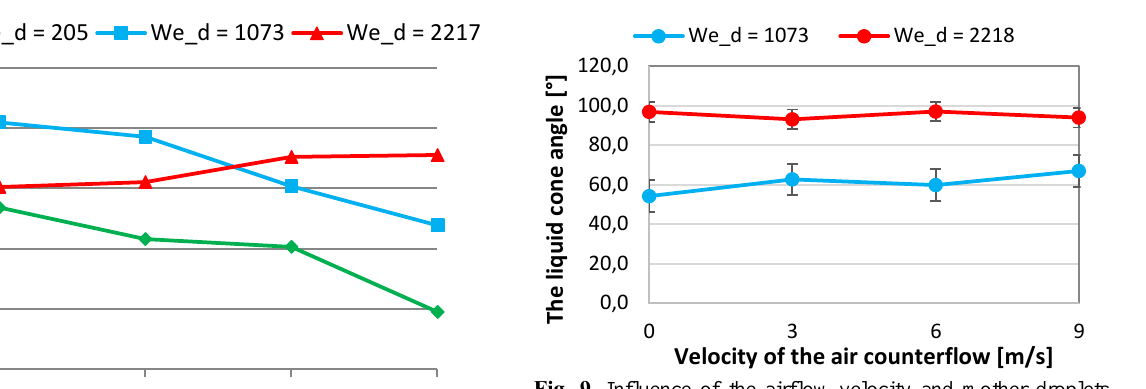
Fig. 9. Influence of the airflow velocity and mother droplets 𝑊𝑒_𝑑 on the cone angle of the liquid dispersion